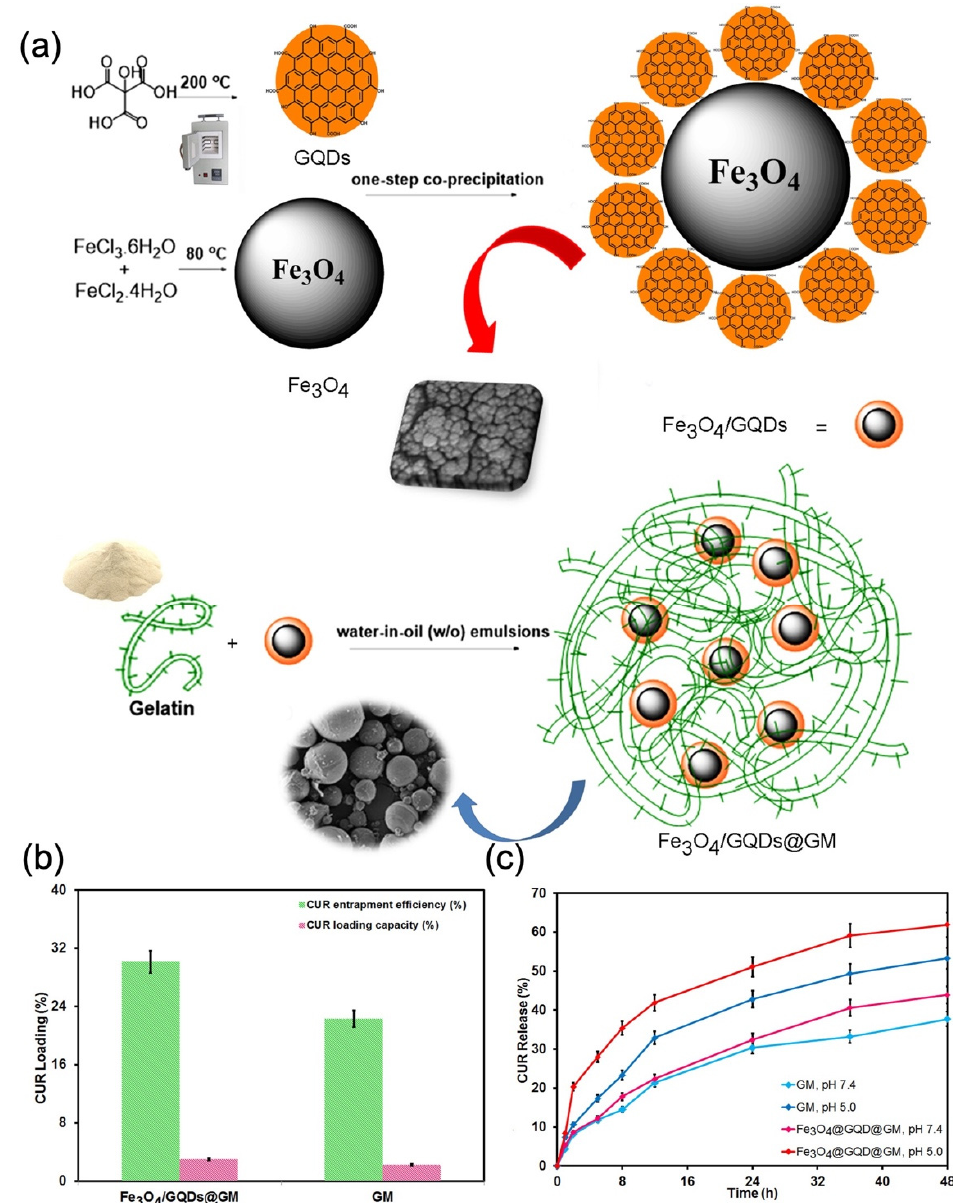
Figure 19. ( a ) Schematic synthesis of Fe 3 O 4 /GQDs@GMs. ( b ) Values of loaded CUR (%) and ( c ) CUR